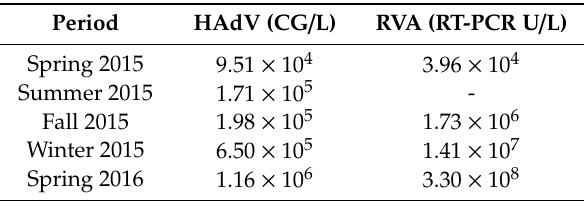
Table 1. Human adenovirus (HAdV) and rotavirus A (RVA) mean viral load during the study period. Quantification analysis of viral load (mean) detected by qPCR (HAdV) and RT-qPCR (RVA) in raw sewage samples collected between spring 2015 and spring 2016 in